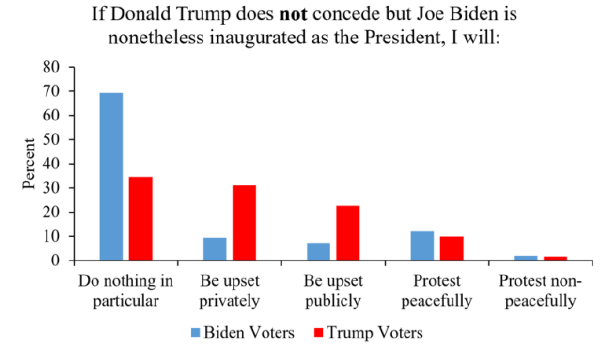
Figure 3. Testing the strength of the belief that Trump won. Few Trump voters believe that Biden has been legitimately elected President (22%). However, many Trump voters would view Biden’s Presidency as legitimate if Trump concedes (51%) or does not concede but loses his various legal challenges